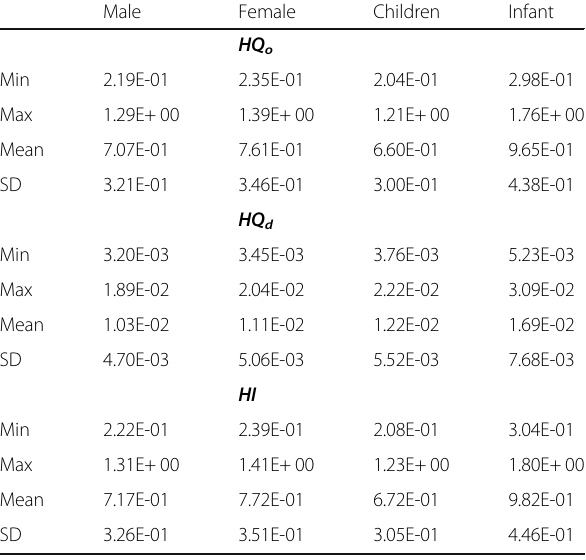
Table 3 Statistics of results of HQ o , HQ d and HI for NO 3 in the studied groundwater